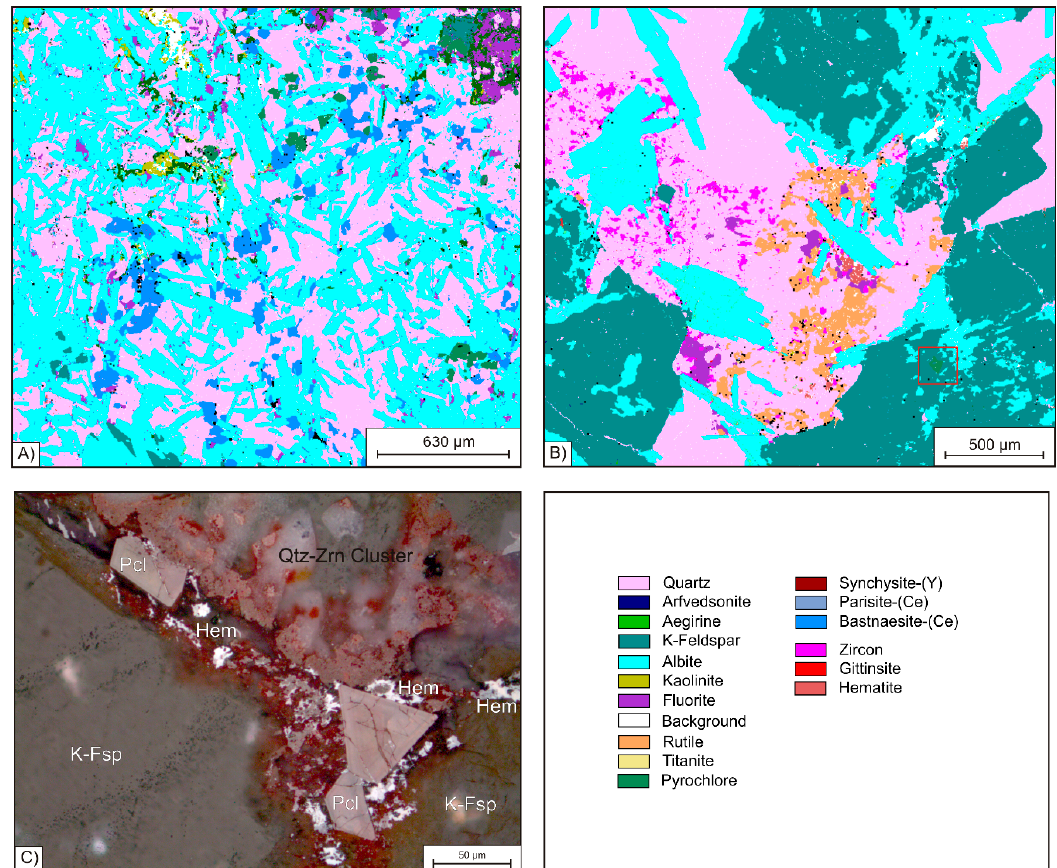
Figure 6. ( A ) Bastnaesite-quartz ore cluster in sample KB S9. K-feldspar is only found as relict. ( B ) Rutile-quartz cluster in granitic sample KB G6 containing fine grained quartz, zircon, fluorite and low amounts of hematite. The box indicates pyrochlore (Pcl) grain within the major association to K-feldspar (K-Fsp), being partly replaced by albite. ( C ) Euhedral pyrochlore on boundaries between K-feldsparand quartz-zircon (Qtz-Zrn) ore cluster. Joints inside the pyrochlore are healed by hematite (hem) precipitation, which also is found around the grains and within the ore cluster (ppl, reflected light, oil).